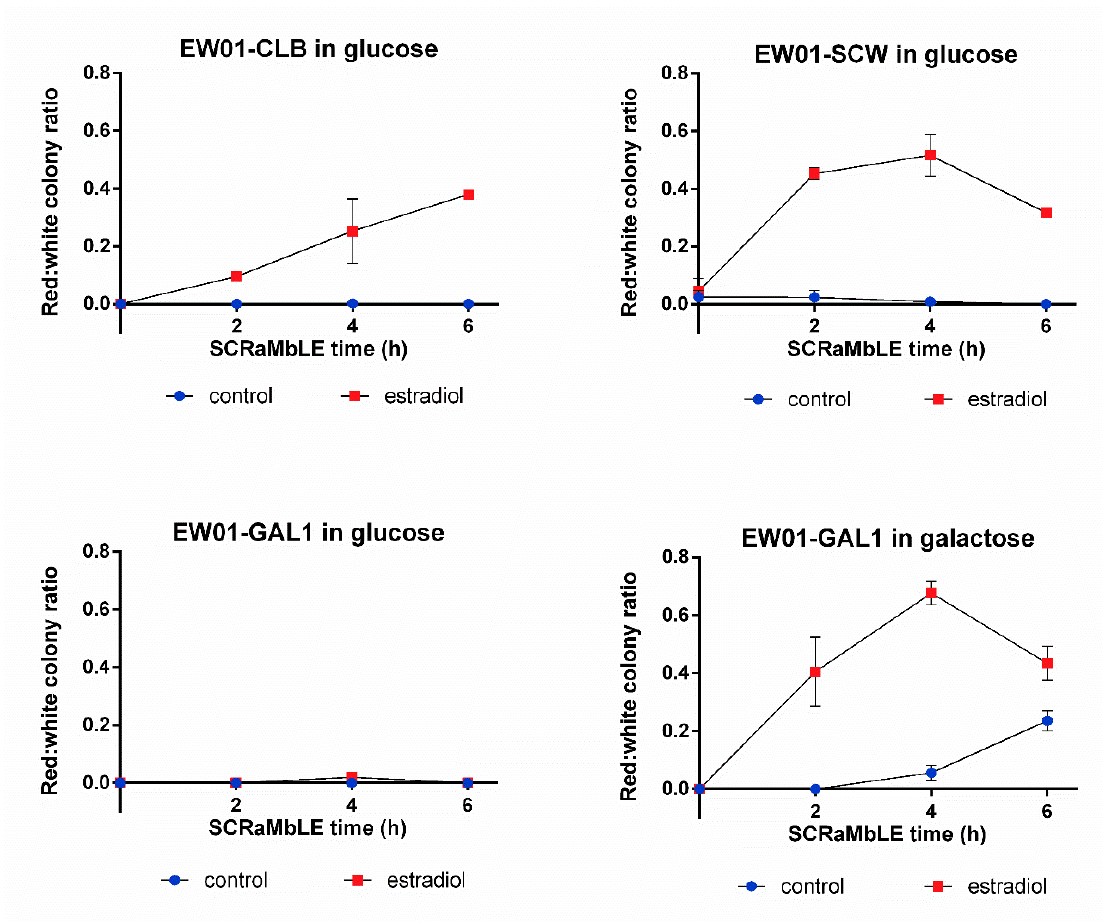
Figure 5. Red:white ratio of S. cerevisiae heterozygous diploid EW01 colonies following SCRaMbLE for up to six hours. Three strains were evaluated (EW01-CLB, EW01-SCW and EW01-GAL) that contained Cre expression plasmids with CRE under the transcriptional control of promoters CLB2 p, SCW11 p and GAL1 p, respectively. Cultures were supplemented with 1 µ M estradiol to induce SCRaMbLEing, while the control cultures received no estradiol. EW01-GAL was cultivated in both inducing (galactose in the absence of glucose) or non-inducing (glucose-containing) conditions. At two-hour time points from 0 h, samples of cells were taken, washed and plated onto YPD agar. The color of colonies was recorded after 72 h.